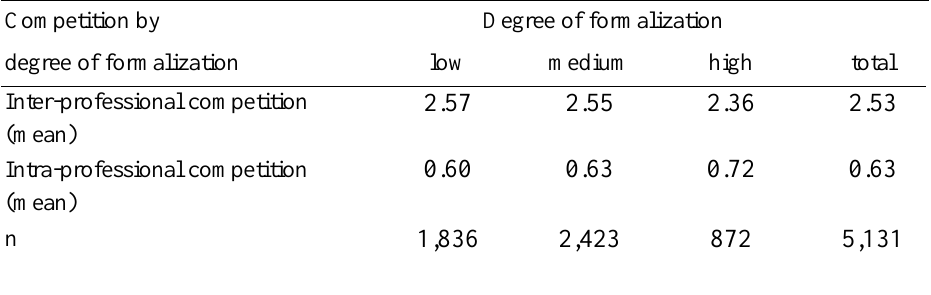
Formalization and professional competition (N = 5,131 tasks) Competition by Degree of formalization degree of formalization low medium high total Inter-professional